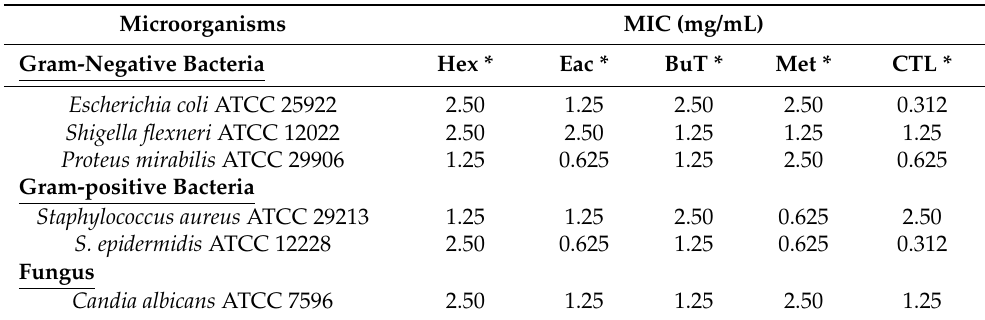
Table 3. Minimum inhibitory concentration (MIC) of the various propolis extracts against micro- bial